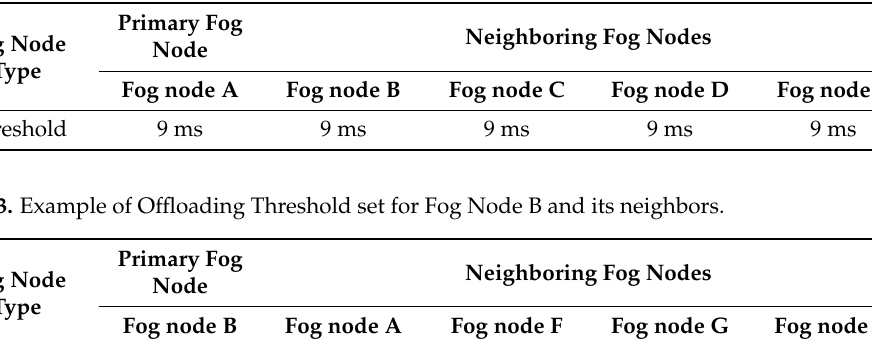
Figure 3. Fog Node Architecture Model. Table 2. Example of Offloading Threshold set for Fog Node A and its neighbors.